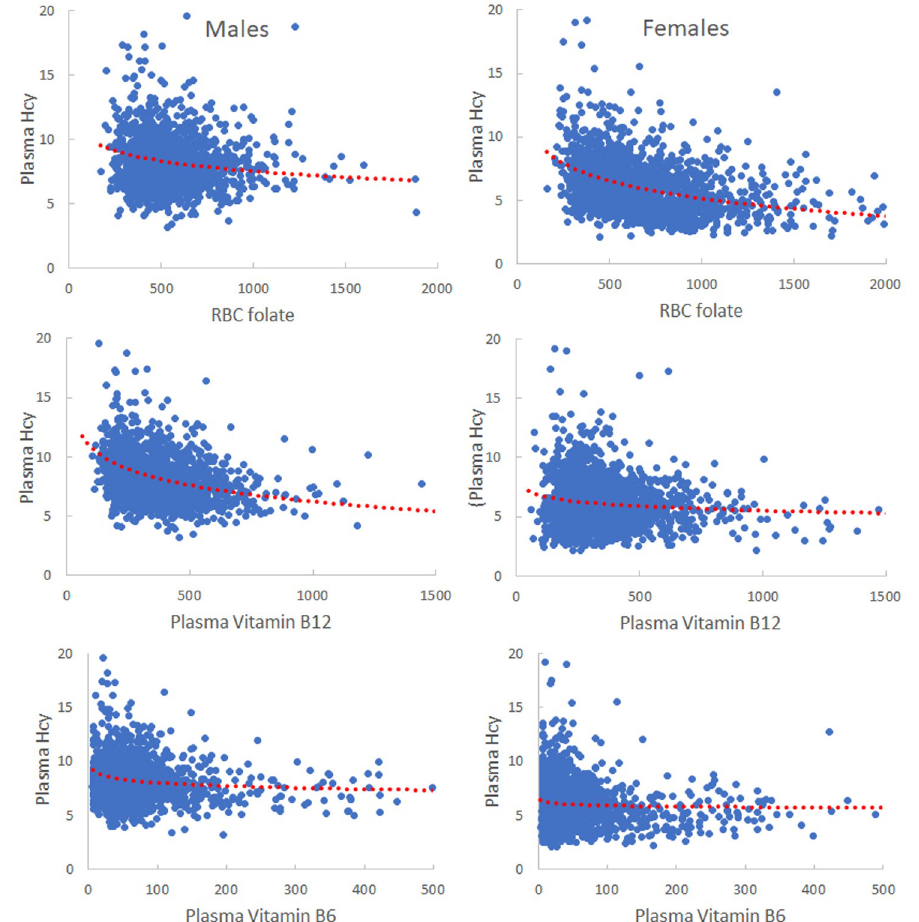
Fig 4. NHANES data on Hcy and vitamin deficiencies. These scatterplots lump together the NHANES studies for 2001–2006. Data is for men and women between ages 20 and 40. The red dotted curves show the mean Hcy concentration of vitamin bins of small size. RBC folate and B 6 are in nanomolar, B 12 is in picomolar, and plasma Hcy is in micromolar. RBC folate stands for red blood cell